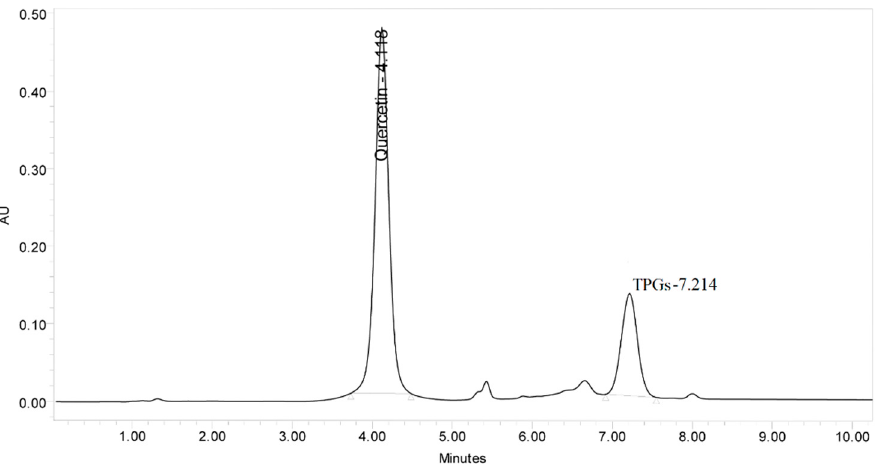
Figure 2. Representative chromatogram of a standard mix of 100 µg/mL quercetin and D- α -Tocopherol polyethylene gly- col 1000 succinate (TPGS) using gradient elution of methanol (A) and phosphate buffer of pH 3 ± 0.1 (B), 50/50 (A/B, v / v ) for 5 min, 98/2 (A/B, v / v ) for 5 min, and 50/50 (A/B, v / v ) for 5 min at flow rate 1 mL/min, 280 nm, and at 25 ± 5 °C.